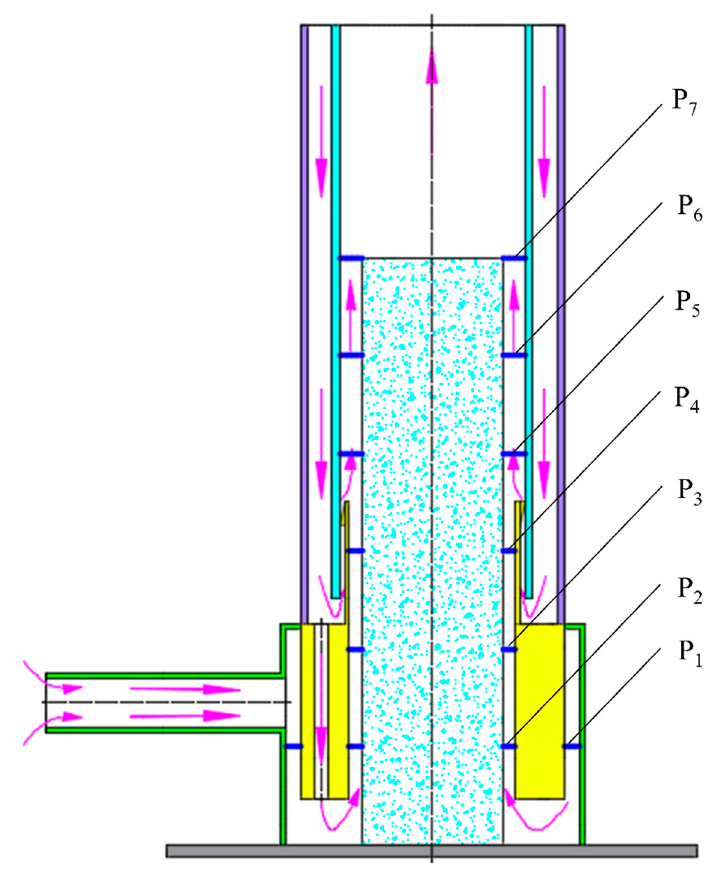
Figure 11. Sketch map of plane position.